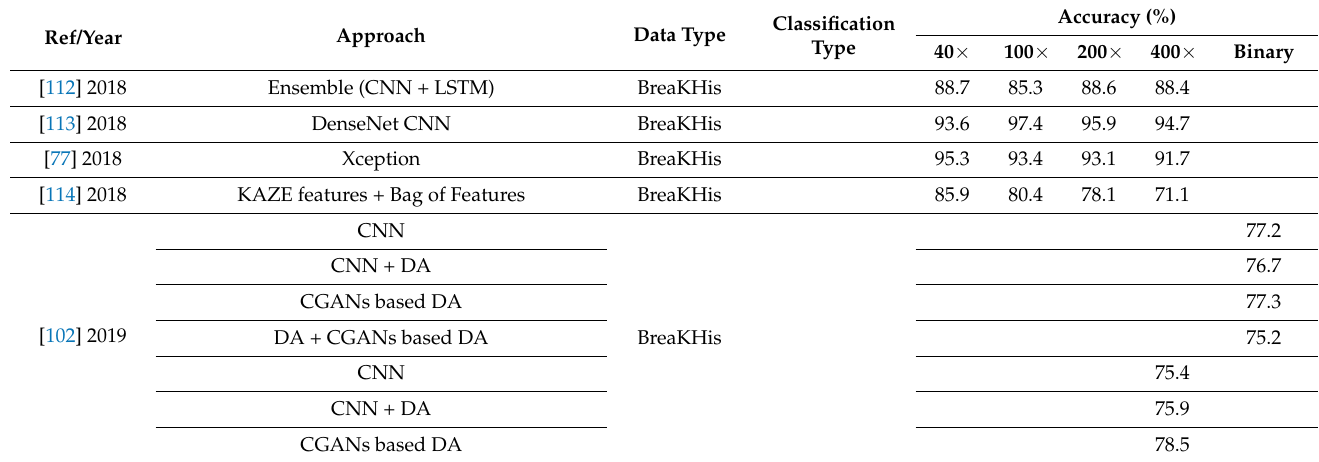
Table 10. Result comparison with the state-of-the-art result using the BreaKHis